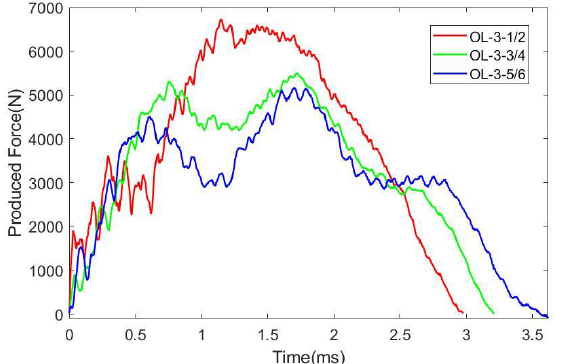
Figure 13. Produced force versus time in impact.